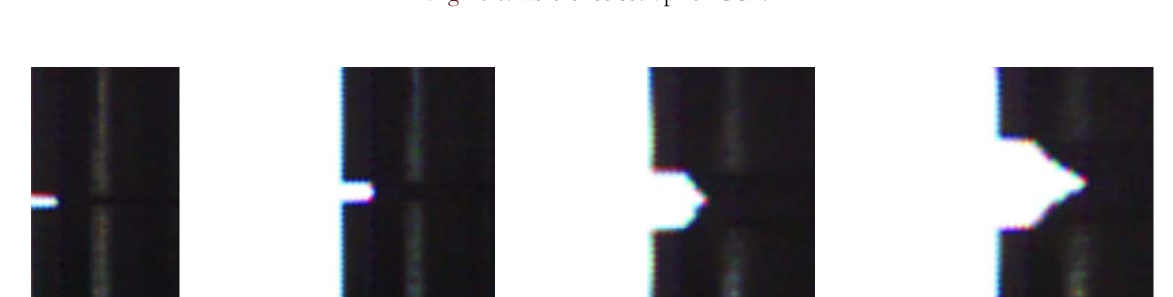
Figure 6: Reference set-up for CCB.